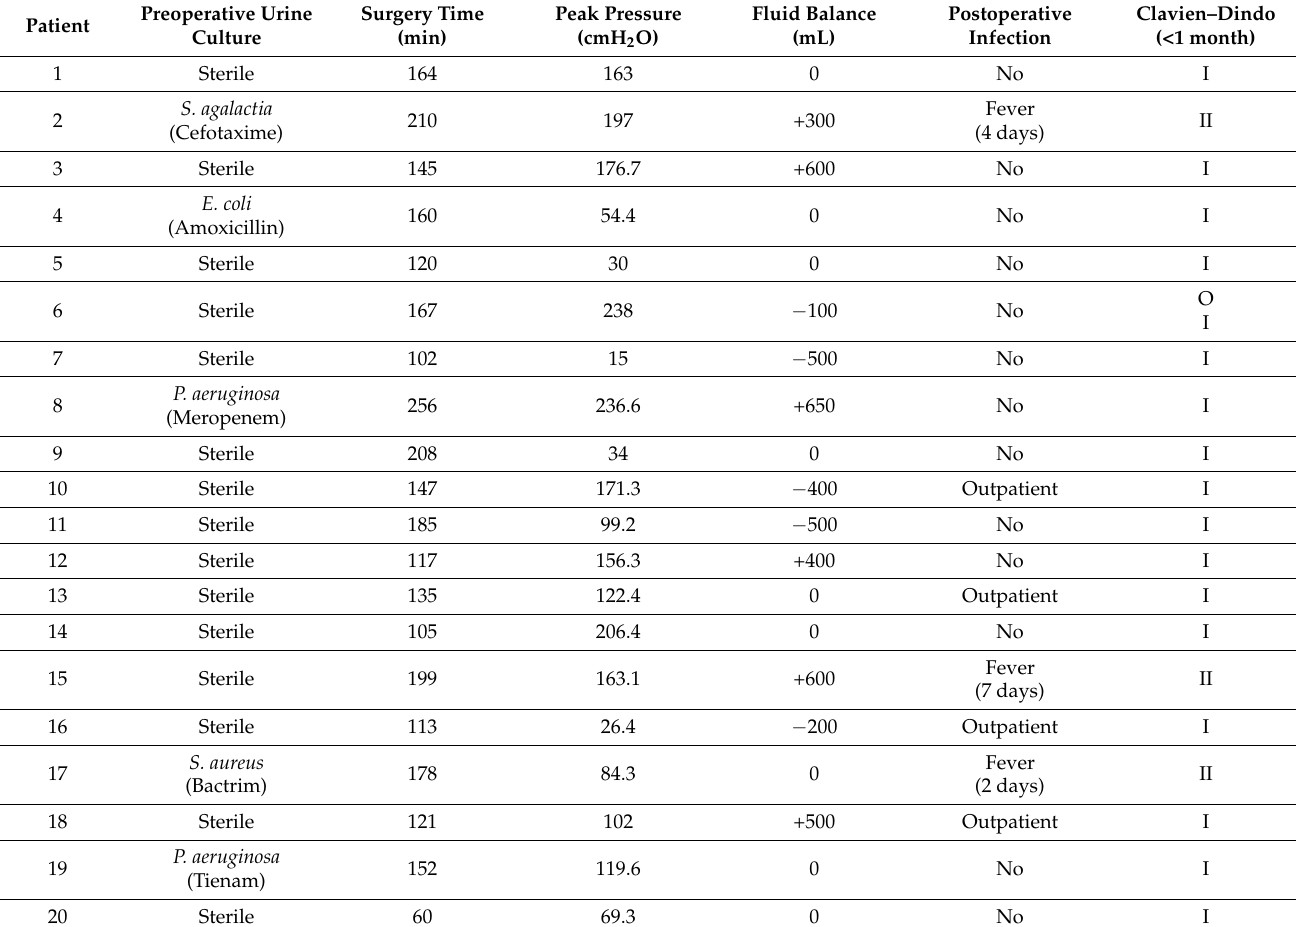
Table 2. Relationship between peak pressure, fluid absorption and postoperative